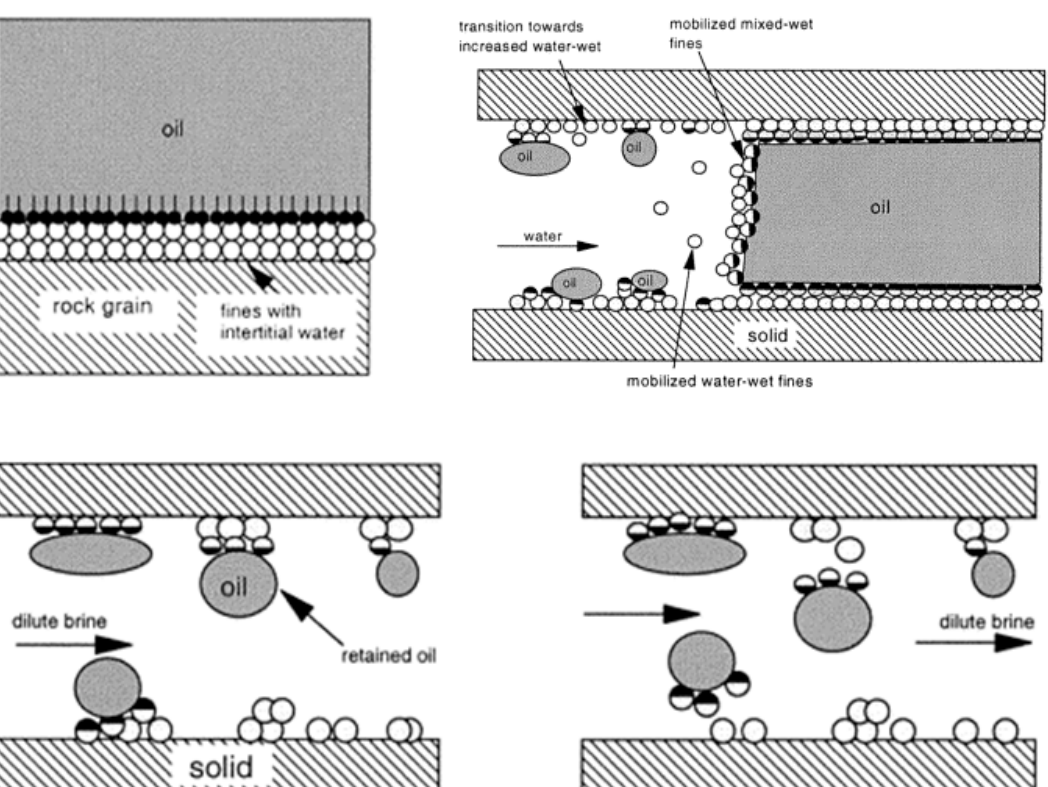
Figure 8. A sketch of proposed wettability alteration by “fines mobilization” in sandstones, showing organic components adsorption to potentially mobile fines forming mixed-wet fines ( left upper ), stripping of mixed-wet fines during low saline brineflood ( right upper ), and residual oil mobilization through fines detachment ( lower ) (reproduced from Tang and Morrow [13] with permission).